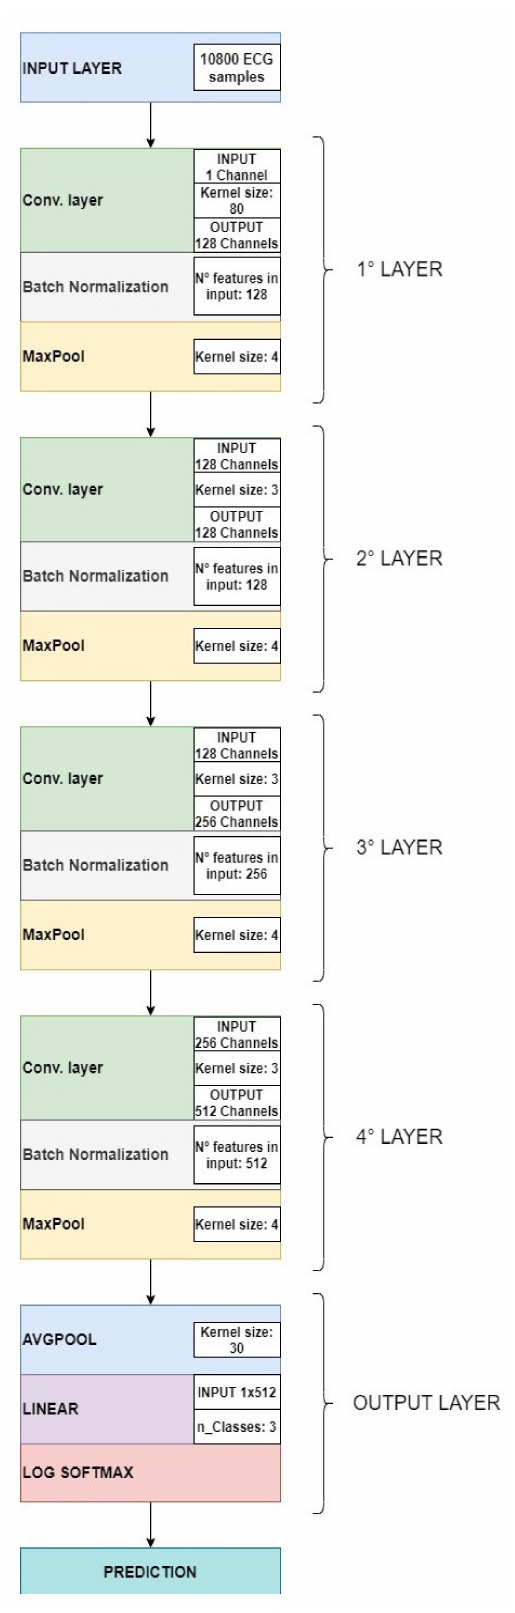
Figure 3. Convolutional neural network